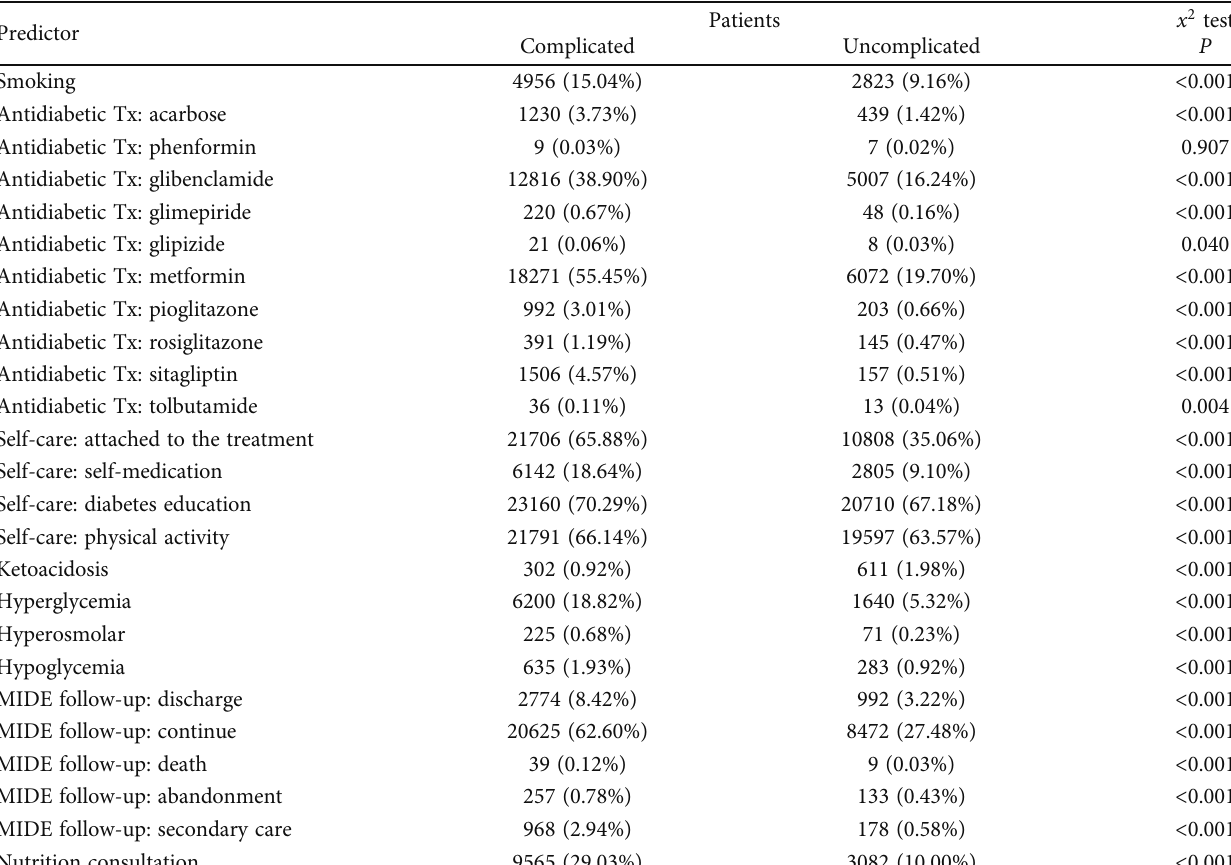
Table 4: Chi-squared test for binary variables between complicated patients versus uncomplicated patients.